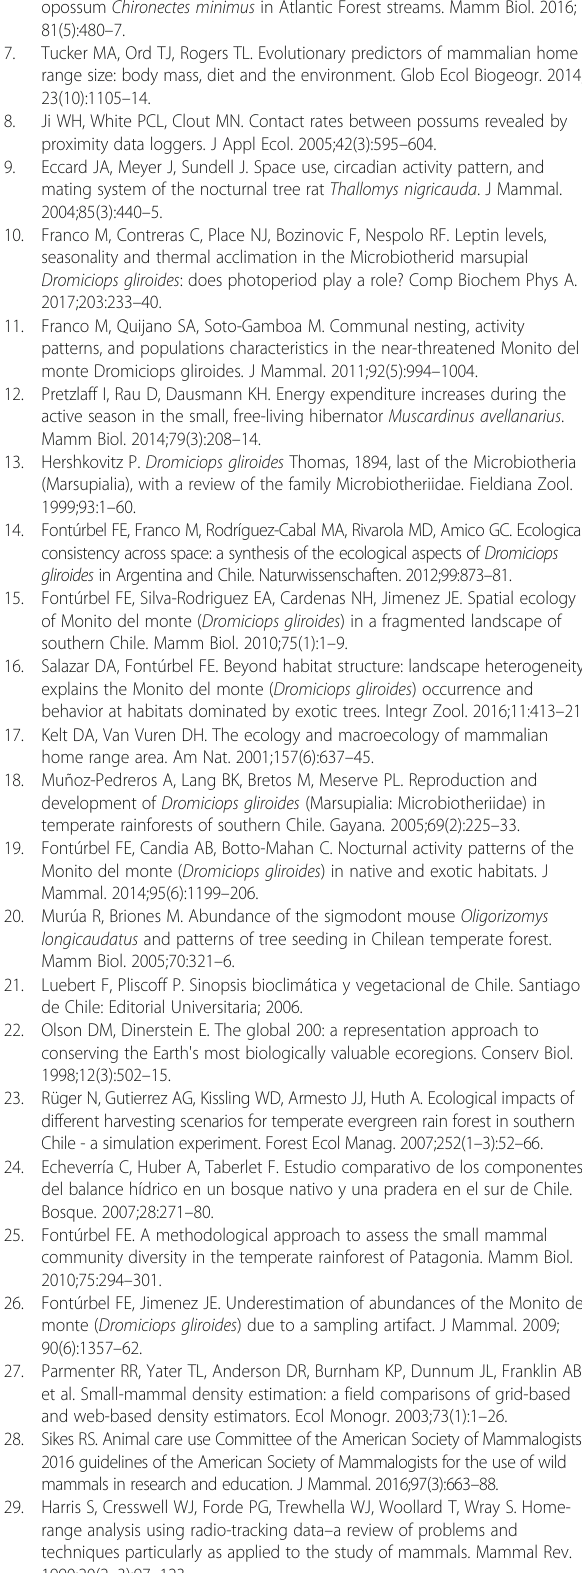
S5. ); detailed GLM results of: body mass comparison between males and females, and between adults and sub-adults ( Table S1. ), home range and core area comparisons between males and females, and between adults and sub-adults ( Table S2. ), home range and core area vs. body mass relationships ( Table S4. ), home range and core area vs. number of locations relationships ( Table S5. ), and movement speed among activity periods ( Table S5.